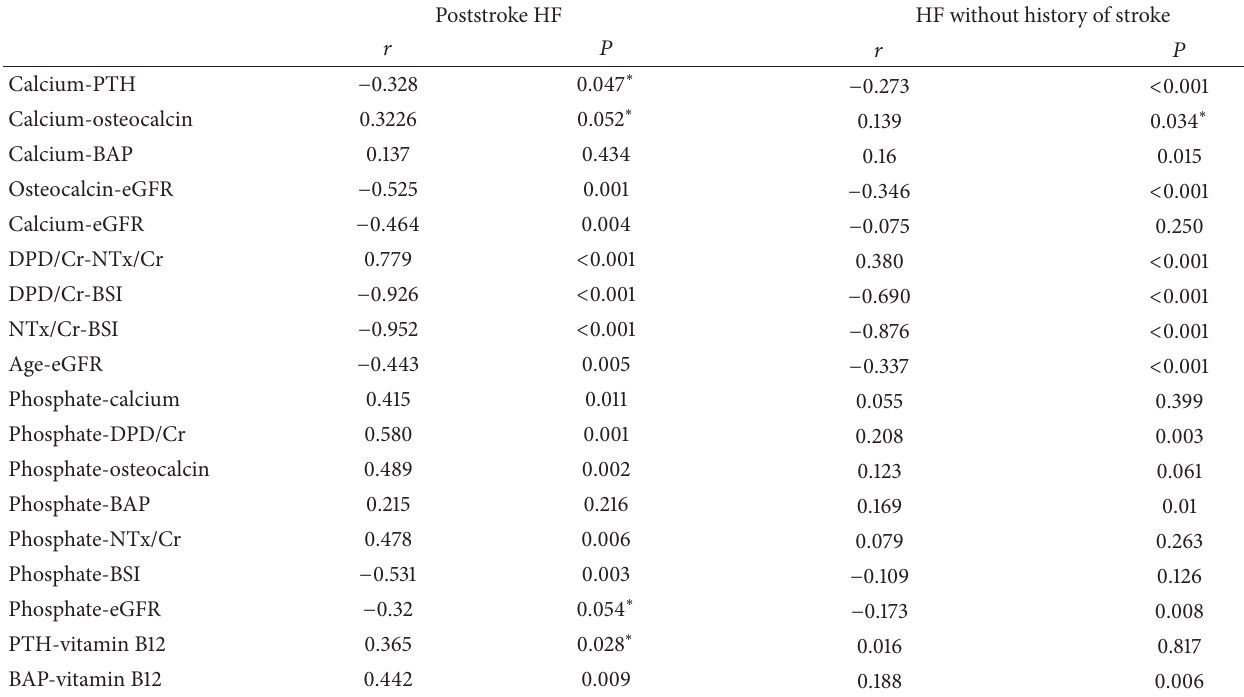
Table 4: Pearson correlation coefficients among selected parameters of mineral and bone metabolism and their relation to age and renal function in older hip fracture (HF) patients with and without history of prefracture stroke.